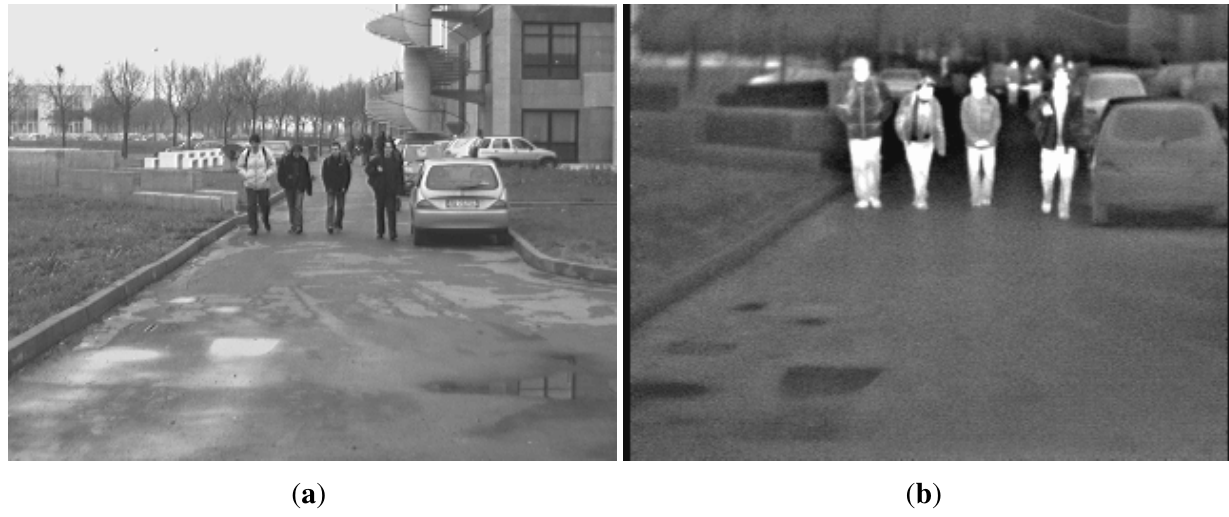
Figure 1. Images examples from the Parma-Tetravision dataset: ( a ) visible spectrum; ( b ) far-infrared spectrum.